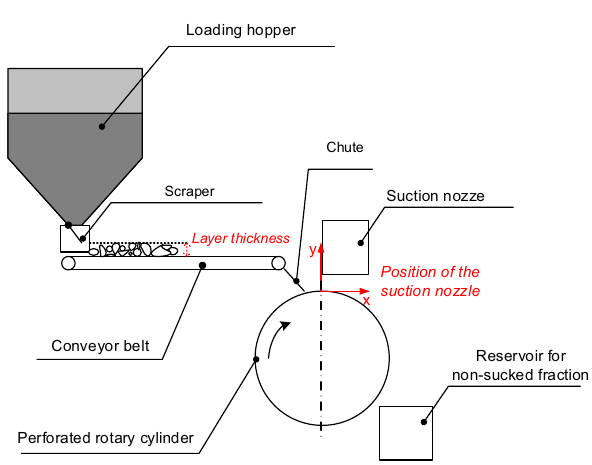
Fig. 3 Diagram of the